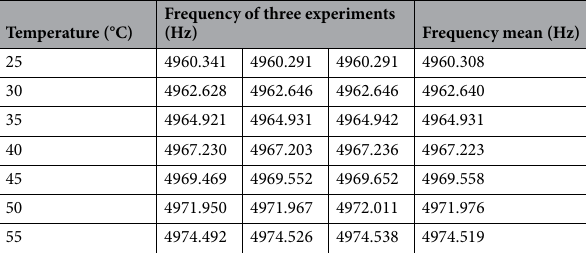
Table 2. Gyro resonant frequency under constant temperature.